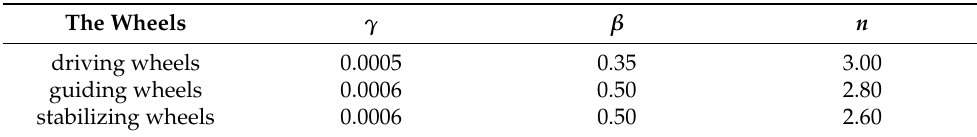
Table 1. Track beam irregularities